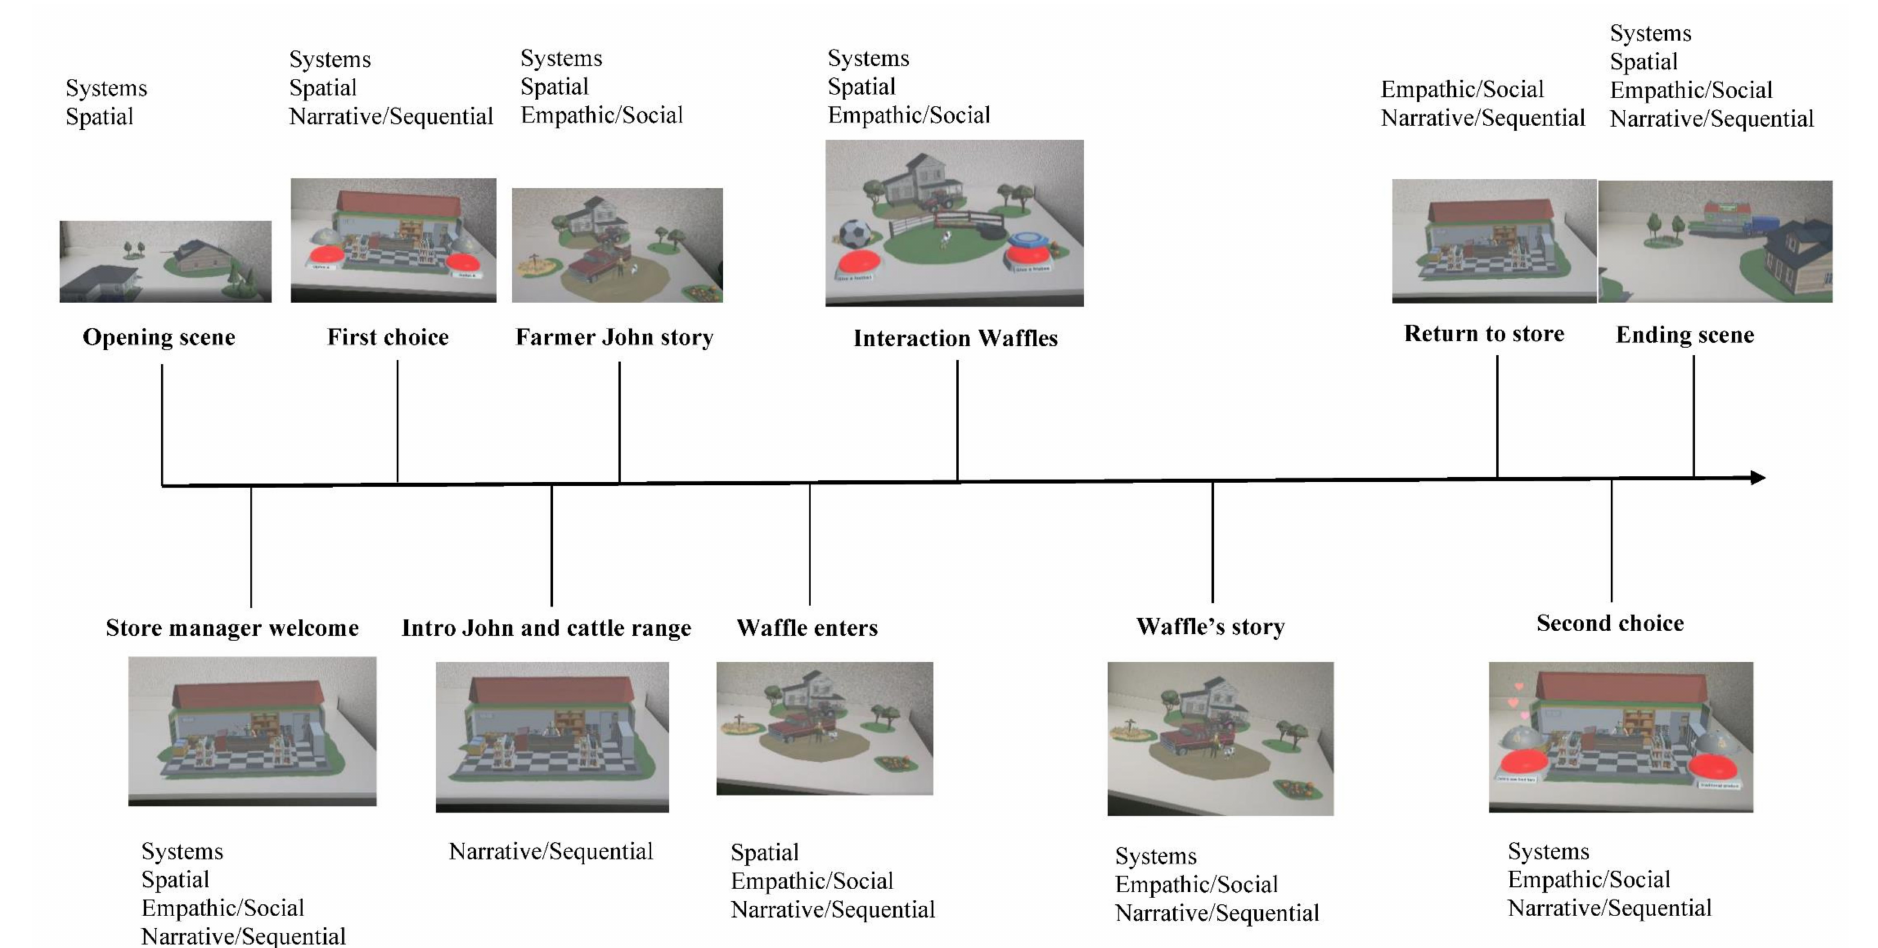
Figure 5. Immersive experience facilitators across the interactive content